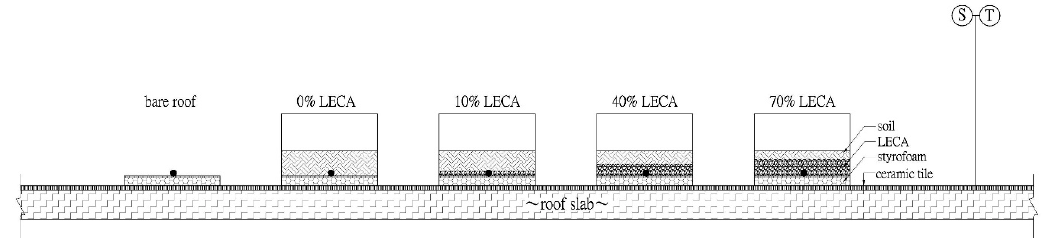
Figure 8. Experimental setup for the second stage. Table 5. Weather data for the second stage (14 July 2017 06:00:09 to 26 July 2017). Second Stage